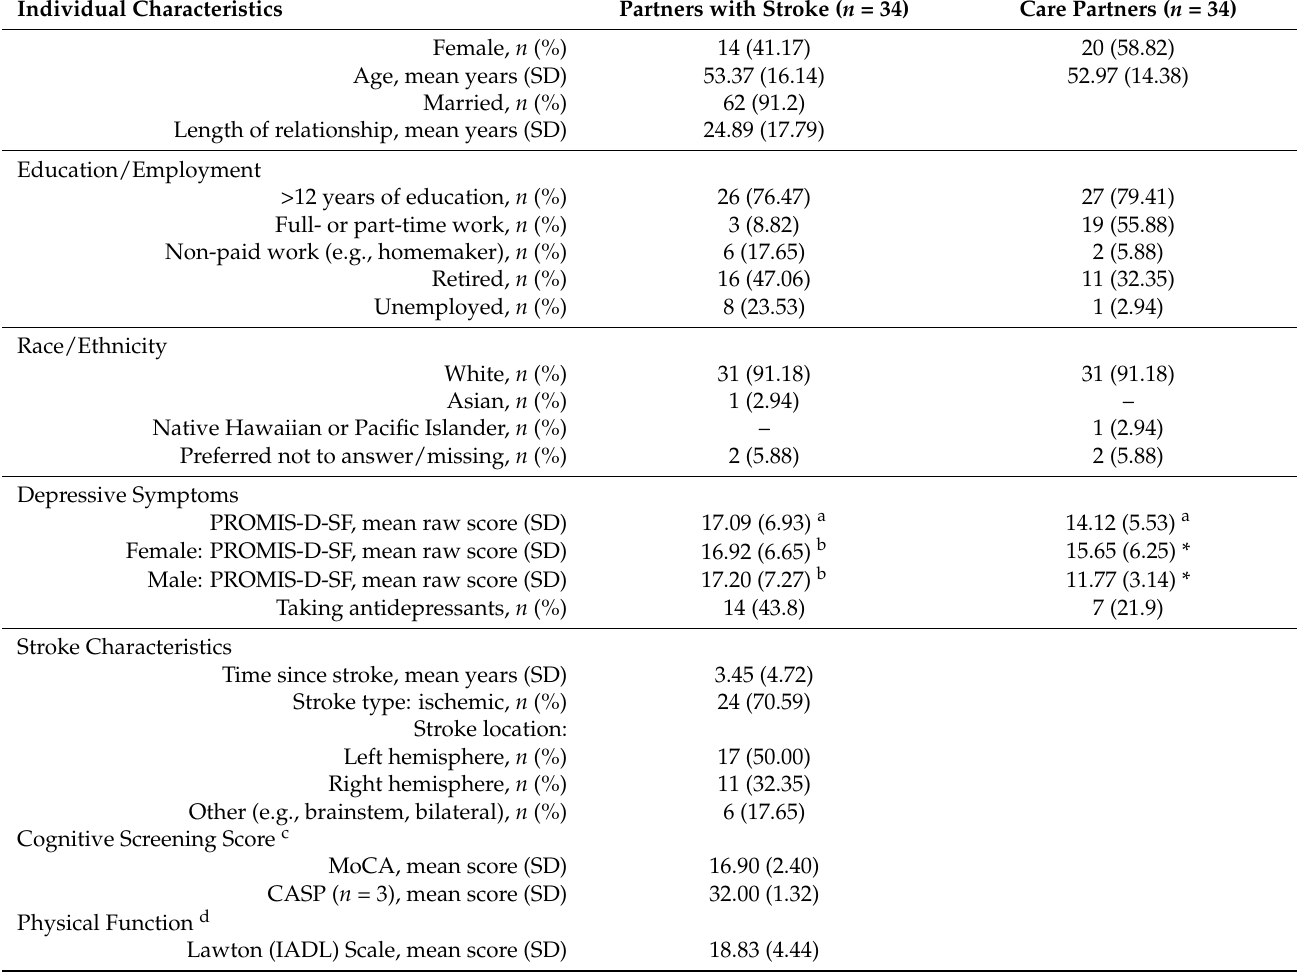
Table 2. Participant characteristics at